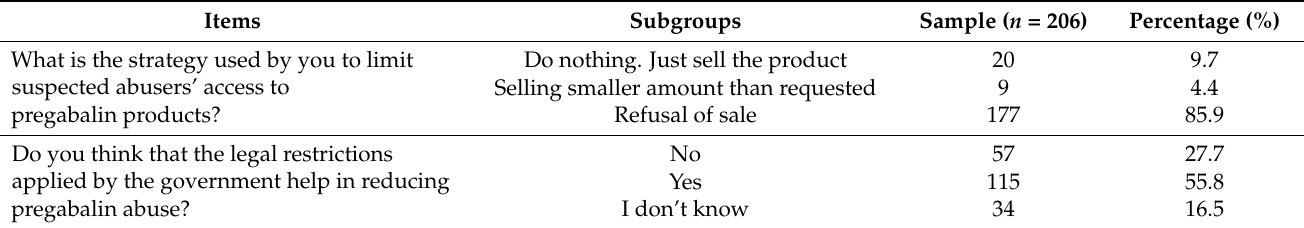
Table 5. Strategy used to limit suspected abusers’ access to pregabalin in the Aseer region ( n = 206).